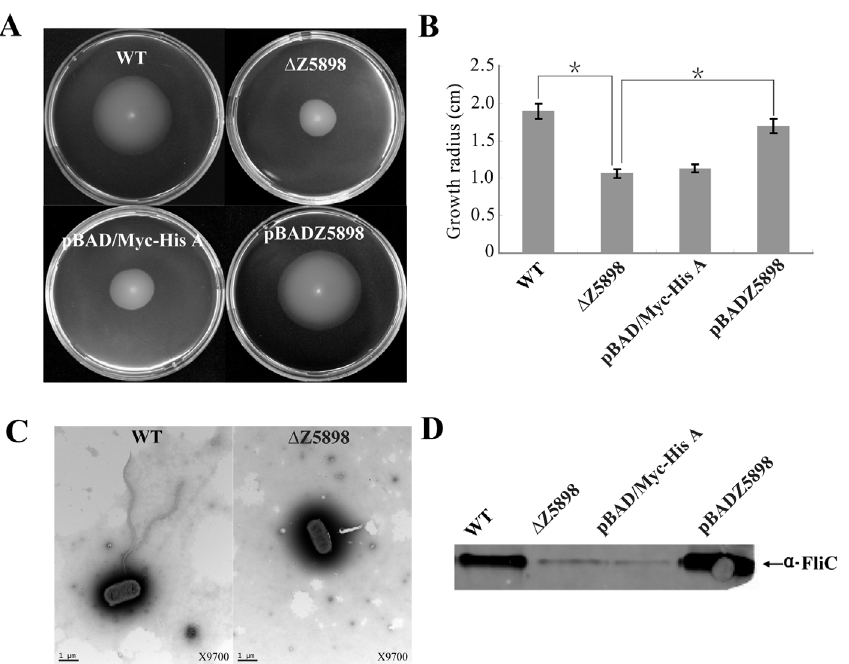
Figure 4. Effects of Z5898 on motility. (A, B) Representative images and growth radius of swimming motility for the wild-type EDL933, Z5898 deletion mutant (EDL933 D Z5898), and complemented strain (EDL933 D Z5898 + pBADZ5898). pBAD/ Myc -His A is an empty vector control. Error bar shows the standard deviation from three independent experiments. Differences were analyzed for significance by using T-test. Significant difference between two strains (P , 0.01) are indicated by a * with a linked line. (C) Transmission electron micrographs of wild-type EDL933 and Z5898 mutant (scale bar, 1 m m). (D) Immunoblot analysis of FliC protein in the whole cell lysates prepared from wild-type EDL933, Z5898 deletion mutant (EDL933 D Z5898), empty vector control strain (EDL933 D Z5898 + pBAD/ Myc -His A) and complemented strain (EDL933 D Z5898 + pBADZ5898) grown in LB. Arrows indicate a reactive band corresponding to FliC detected with anti-H7 FliC antibodies.